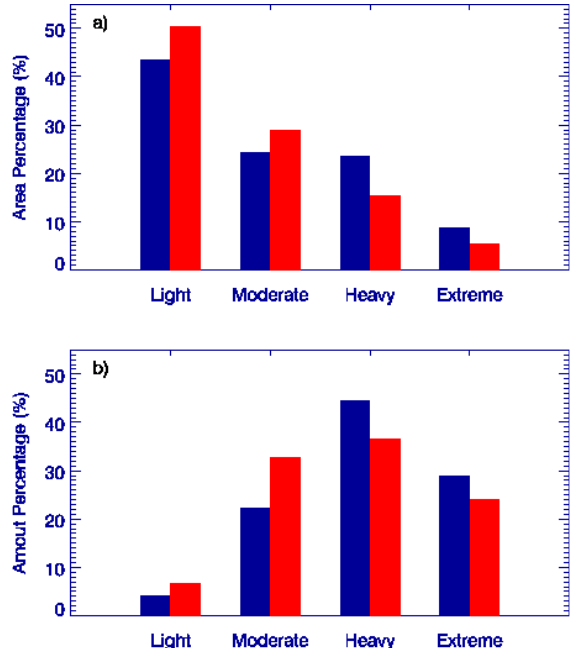
Figure 10. Fig. 10. Probability distribution functions of the four different rain- fall categories, i.e. light ( < 10mmd − 1 ) , moderate (10–25mmd − 1 ) , heavy (25–50mmd − 1 ) and extreme heavy ( > 50mmd − 1 ) rain, simulated for the P- and C-cases. (a) Percentage of grid areas un- der a certain precipitation category over the entire model domain. (b) Percentage of the precipitation amount under a certain category over the total precipitation amount. Dark blue corresponds to the P-case, and red corresponds to the